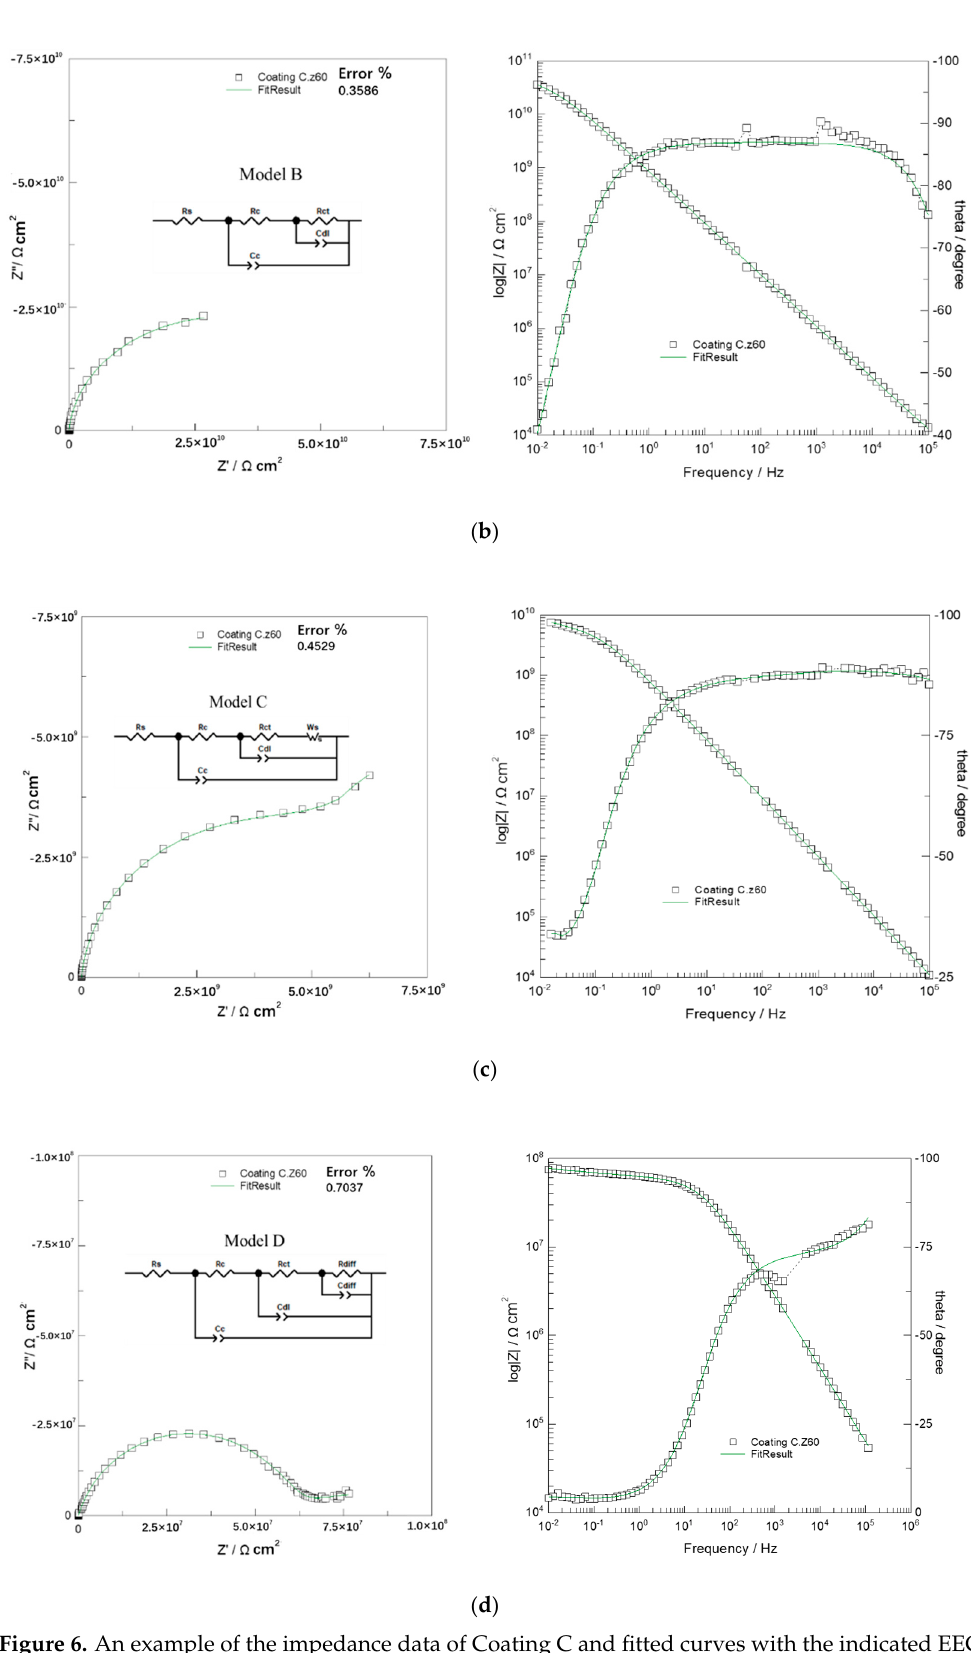
Figure 6. An example of the impedance data of Coating C and fitted curves with the indicated EEC models. ( a ) 0.5 h; ( b ) 150 h; ( c ) 690 h; ( d ) 1050 h.